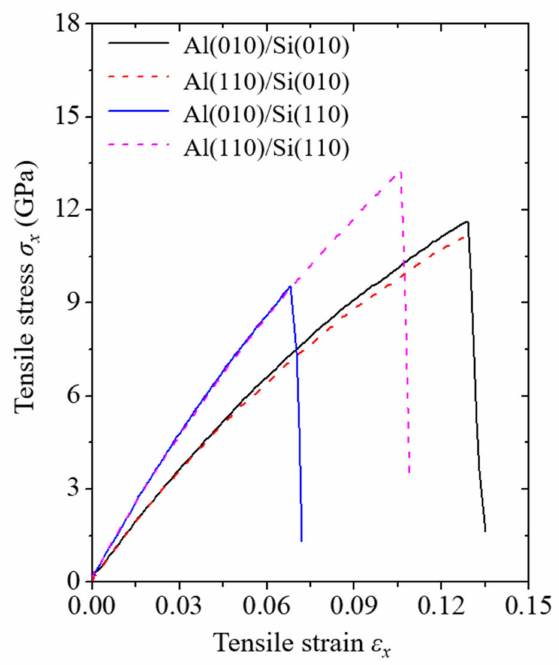
Figure 2. Stress–strain curves of the four simulation models under tension. The nanofilm thickness in the simulation models used for the stress curves is approximately 3